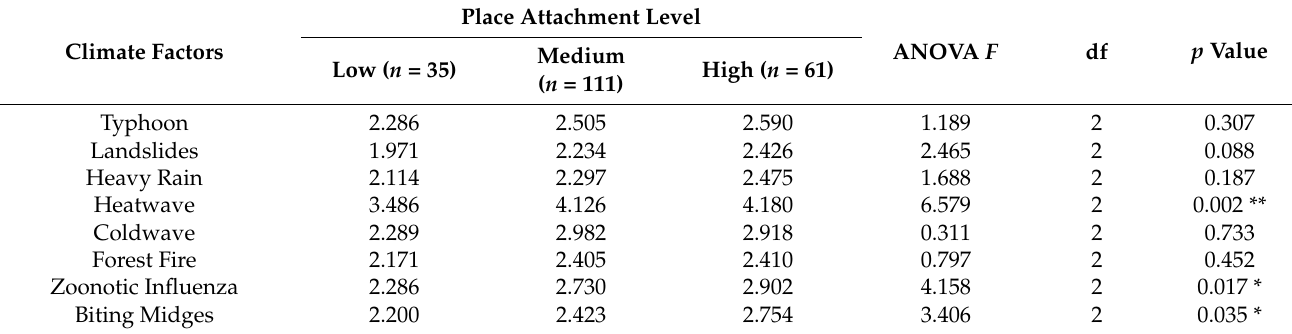
Place Attachment Level